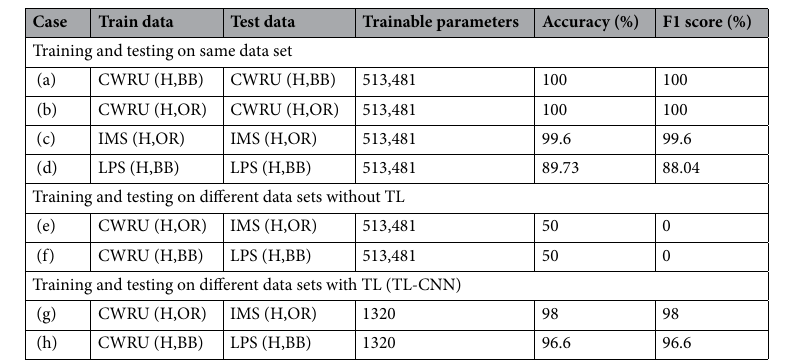
Table 3. CNN performance results on various data sets using scalograms as inputs.